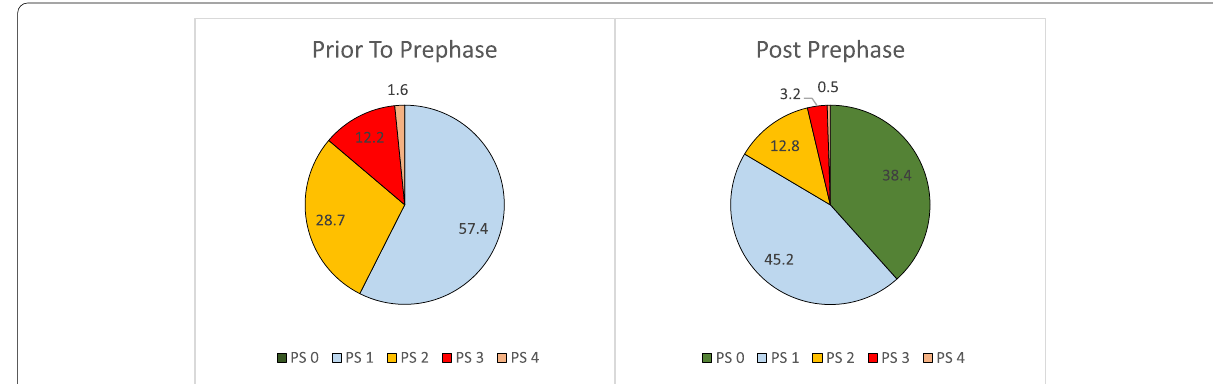
Fig. 1 Comparison of ECOG performance status of patients prior to and post-pre-phase therapy